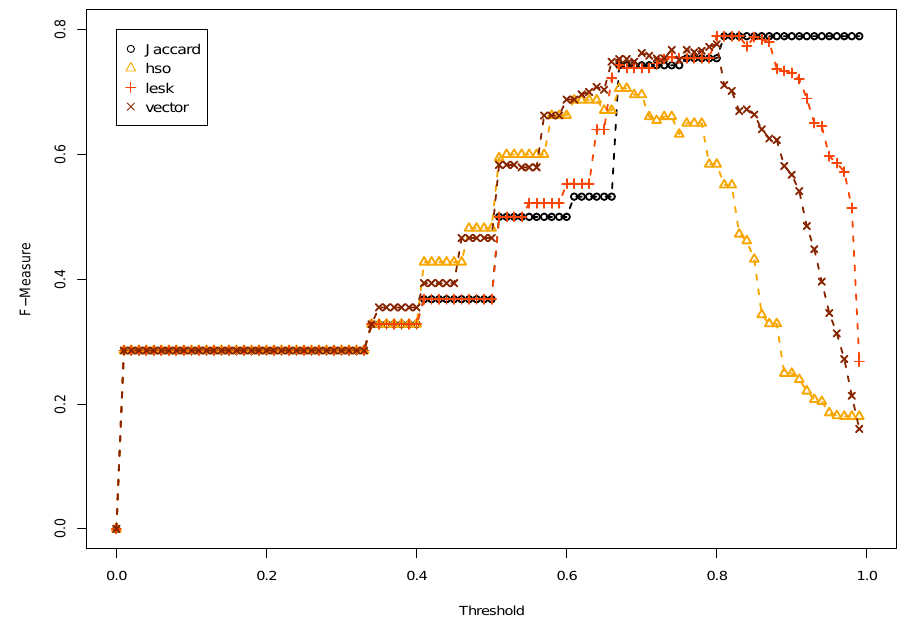
Figure 6. Semantic dissimilarity evaluation using word similarities derived from WordNet, based on word relatedness measures.